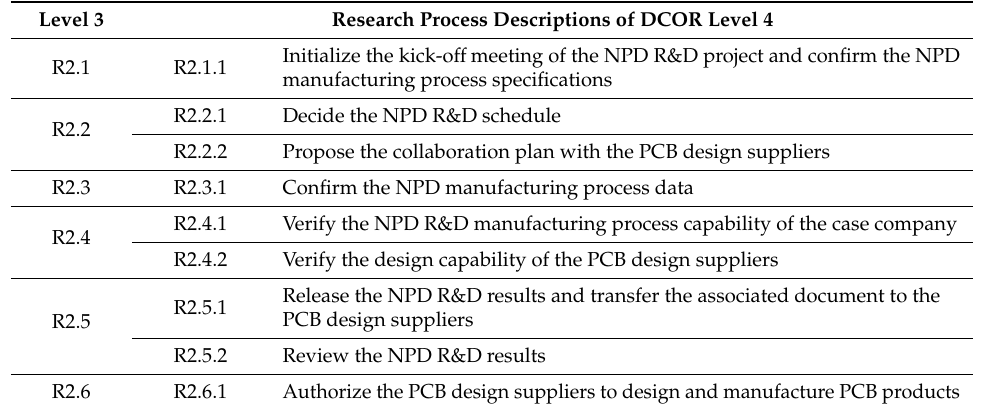
Table 2. Research process of DCOR Level 4.